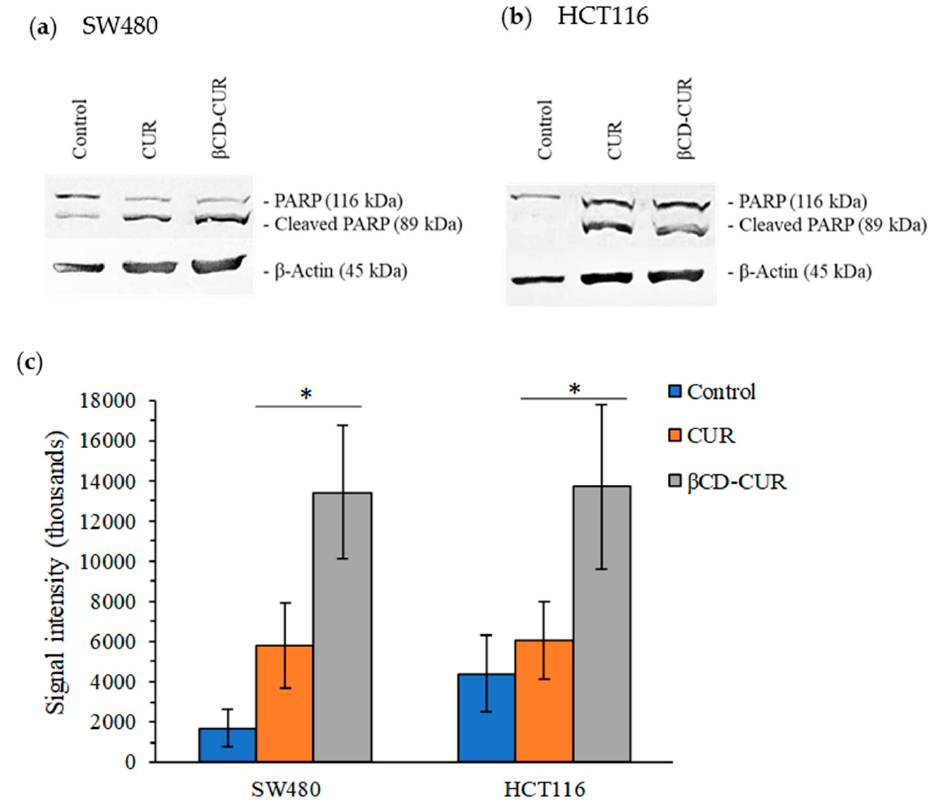
Figure 8. Induction of apoptosis through the activation of caspase-3 and subsequent cleavage of full-length PARP enzymes (116 kDa) into a large (89 kDa) subunit protein, with β -actin as a loading control for ( a ) SW480 cells and ( b ) HCT116 cells. ( c ) Cleaved PARP normalized to β -actin. Data for cleaved PARP were presented as mean ± S.D. of three independent replicates. Statistically significant changes between CUR and β CD-CUR groups are denoted as (*) with a p <